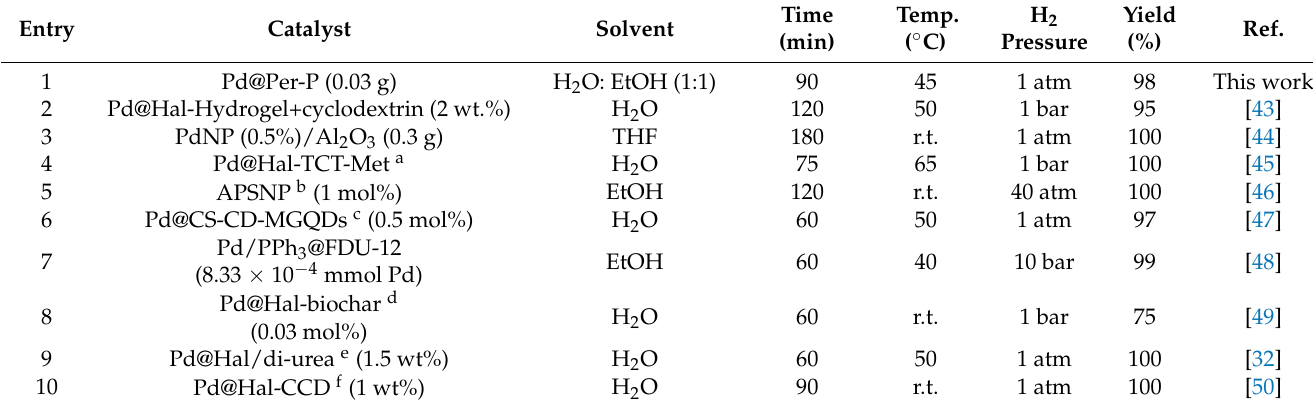
Table 3. The comparison of the activity of Pd@Per-P for the model hydrogenation reaction.